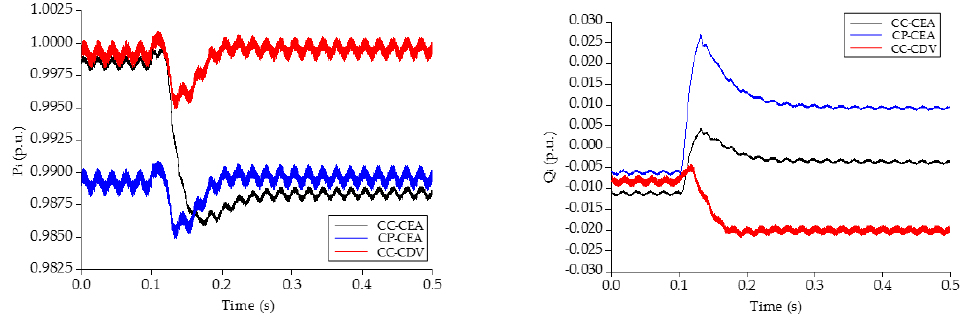
Figure 9. Change of power injection into converter bus under different control modes. ( a ) active power;